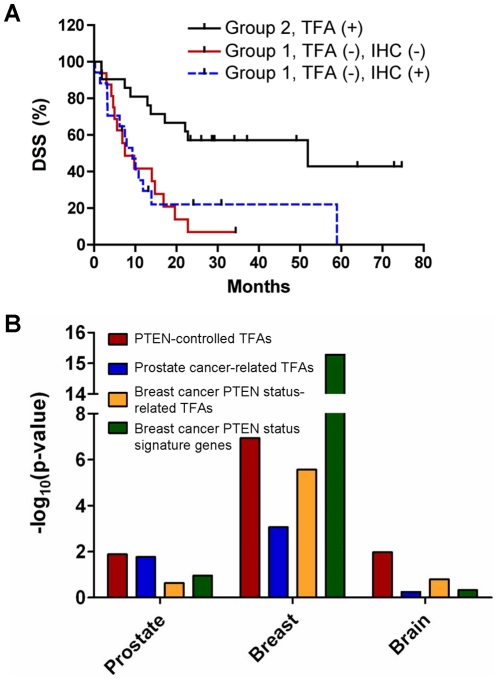
Enhanced robustness of TFA-based signatures in predicting PTEN status in human cancer.(A) The Kaplan-Meier survival curves of patients with brain tumors stratified according to PTEN-controlled TFA and IHC analyses. (B) Log10 transformed p-values of the χ2 test evaluating the association of PTEN status with the hierarchical clustering-determined groups of human tumors. Clustering results are based on PTEN-controlled TFAs (red; Figure 3), prostate cancer-related TFAs (blue), TFA-based (gold) and gene expression-based (green) signatures derived from PTEN IHC data in breast tumors. When three major clusters are observed in prostate and breast cancers, the χ2 tests are performed to associate different PTEN status in group 1 and groups 2 plus 3.